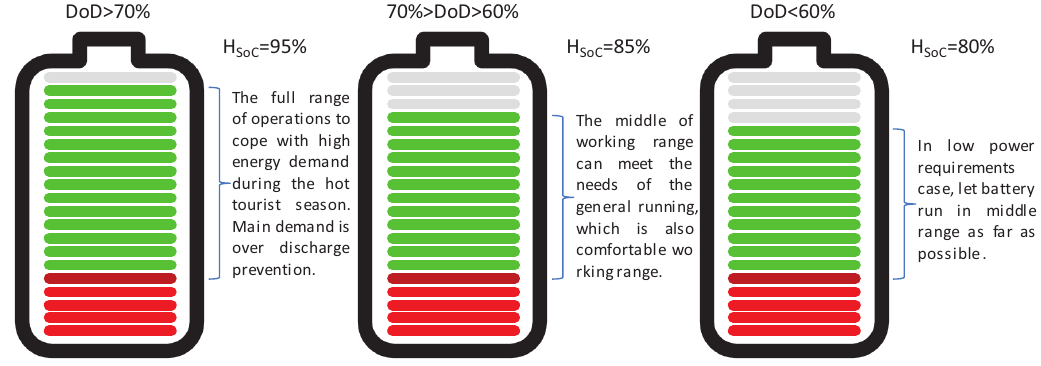
Figure 12. The SoC operation range correction in different